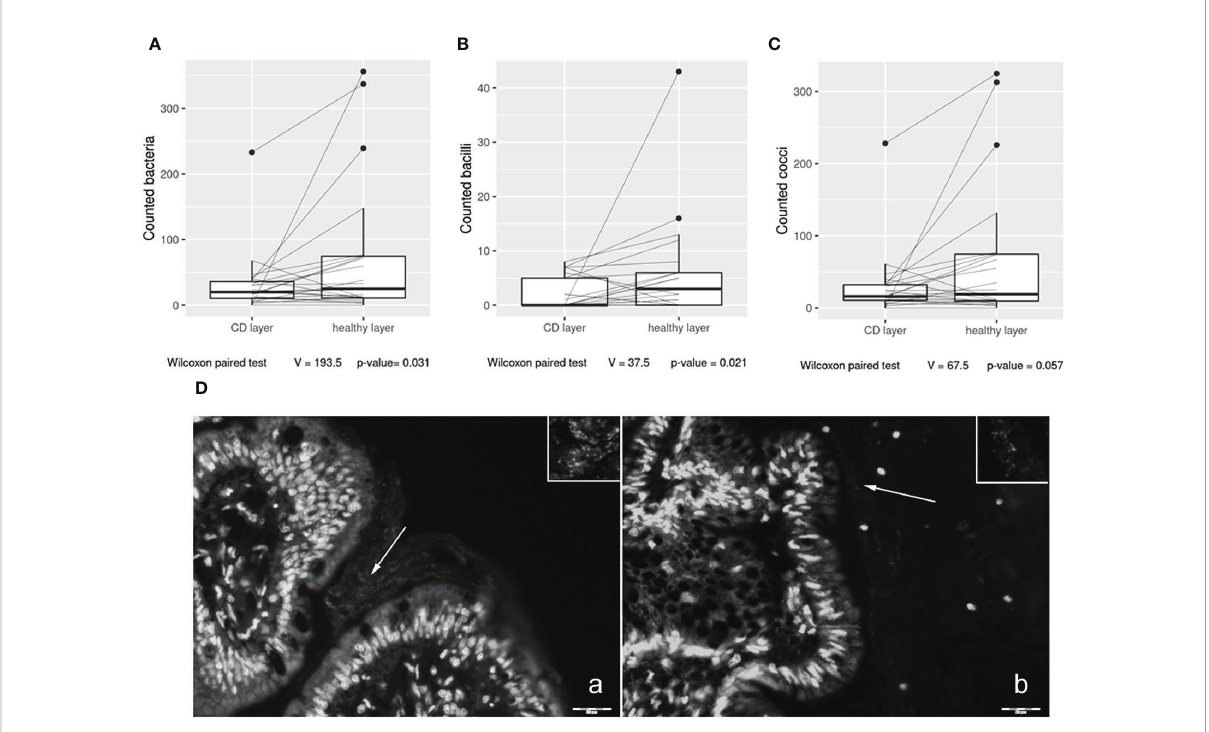
FIGURE 1 Box plot distribution of adherent bacteria counts (A) , bacilli (B), and cocci (C) identi fi ed in healthy tissues and Crohn ’ s disease (CD) samples. Analyses were assessed using the paired Wilcoxon signed – rank test, and p – values less than 0.05 were considered statistically signi fi cant. Mucosa – associated bacteria in histological samples (D) . Images collected at ×400 magni fi cation indicate (A) H mucosa sample and (B) CD sample. White arrows: bacteria present in the mucus contiguous to the mucosa. Insert magni fi cation: bacteria. Scale bar: 20 µm.